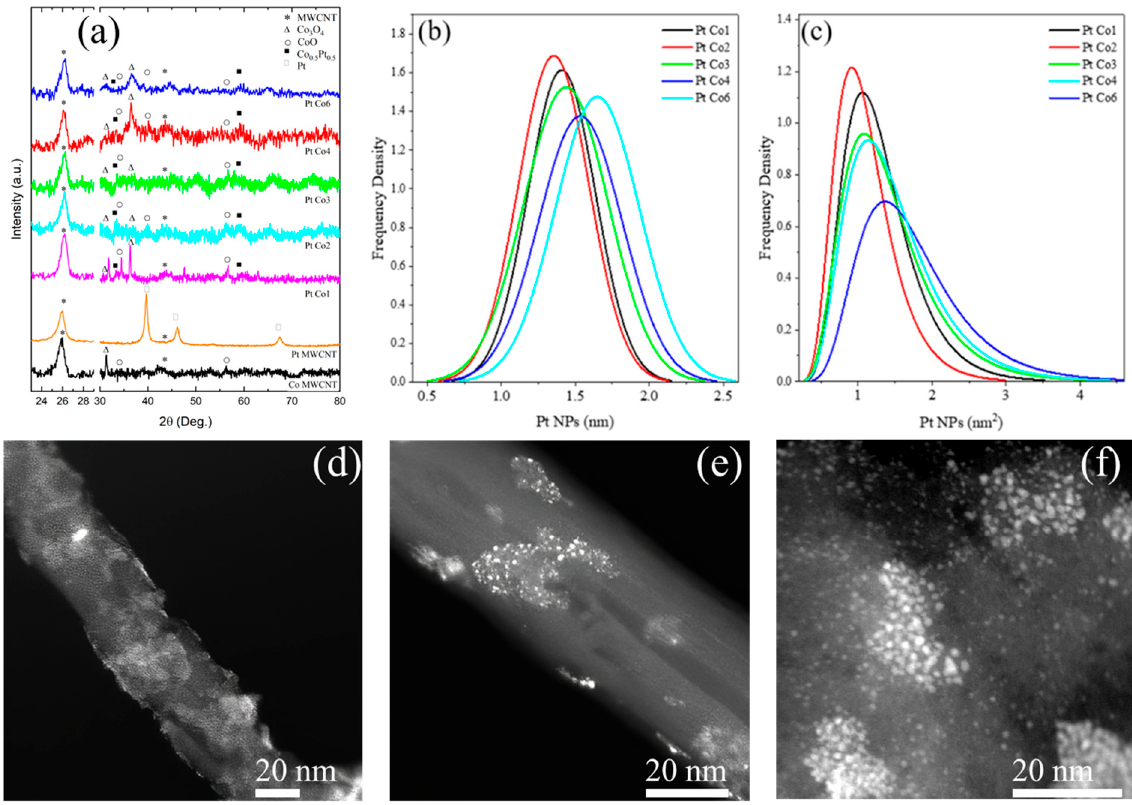
Figure 1. ( a ) XRD analysis, ( b ) Pt size distribution, ( c ) Pt NP area distribution, and ( d – f ) HRTEM images of the PtCo/MWCNT 4 catalyst.